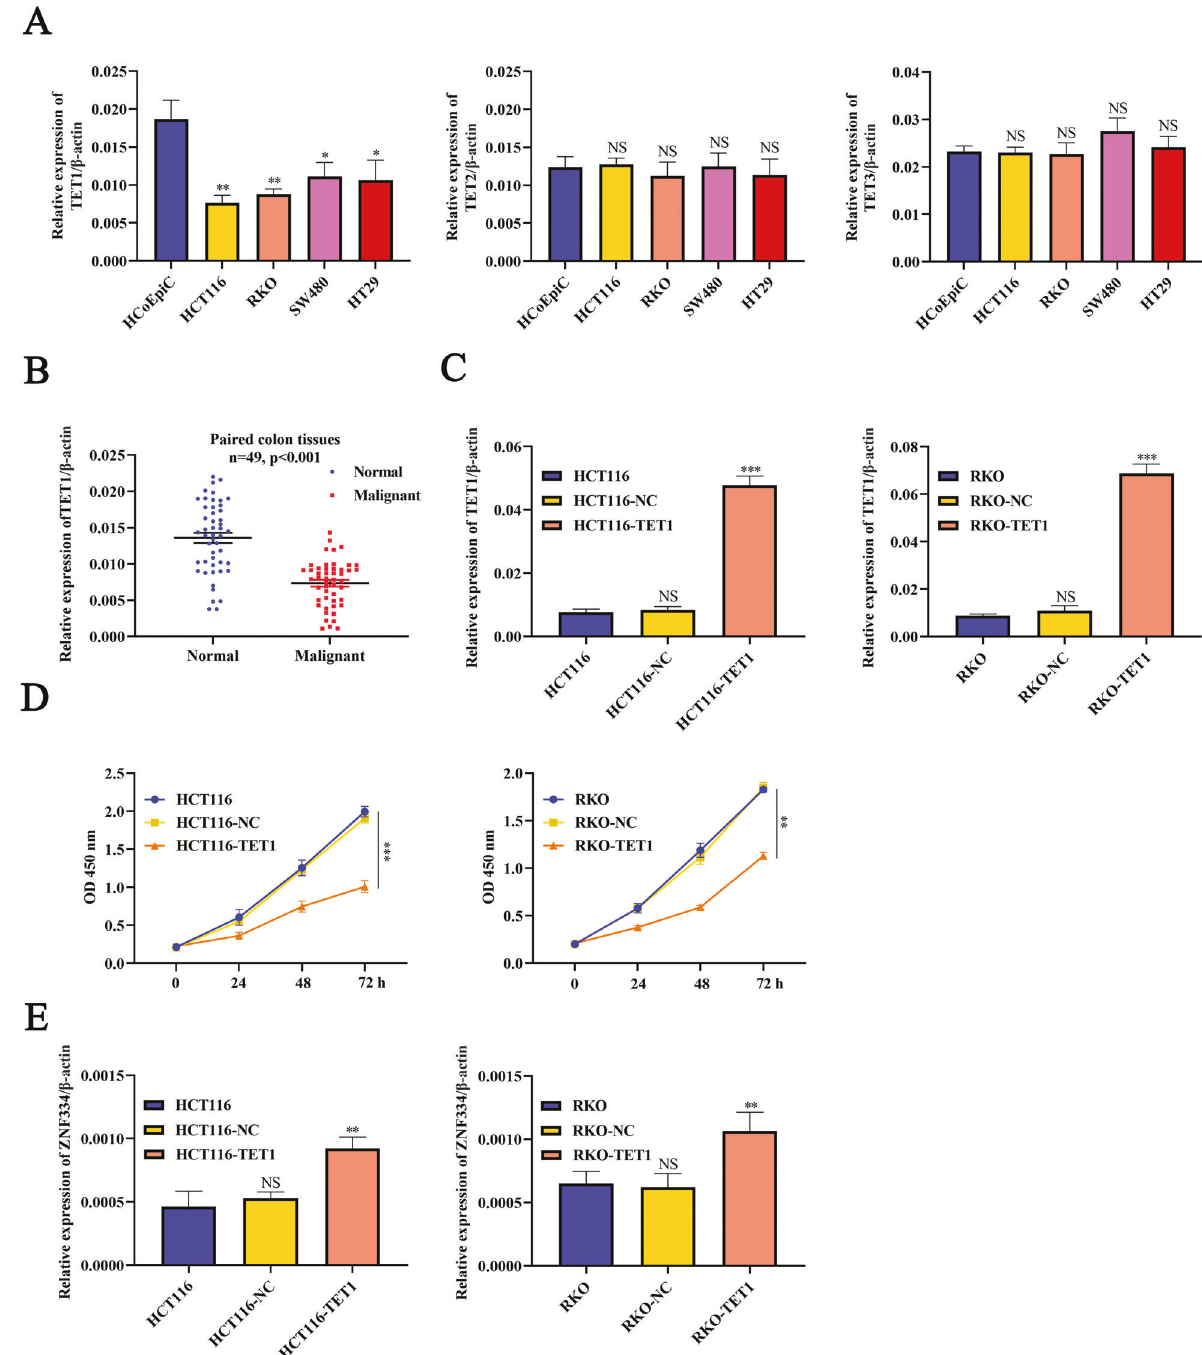
Fig. 3 Demethylation of ZNF334 by TET1. A The expression of TET1, TET2, and TET3 in HCoEpiC and CRC cells. Data are shown after normalization to β -actin ( n = 3, * p < 0.05; ** p < 0.01, compared with the HCoEpiC group). B TET1 mRNA expression in paired CRC tissues ( n = 49, p < 0.001). C TET1 mRNA expression in HCT116 and RKO cells after pLVX-MYRF-TET1 infection. Data are shown after normalization to β -actin ( n = 3, *** p < 0.001, compared with the blank group). D A CCK8 assay was performed to determine the growth of HCT116 and RKO cells transfected with pLVX-MYRF-TET1. ( n = 3, ** p < 0.01; *** p < 0.001, compared with the blank group). E ZNF334 mRNA expression of HCT116 and RKO cells transfected with pLVX-MYRF-TET1. Data are shown after normalization to β -actin ( n = 3, ** p < 0.01, compared with the blank group). The primer sequences are listed in Supplementary Table